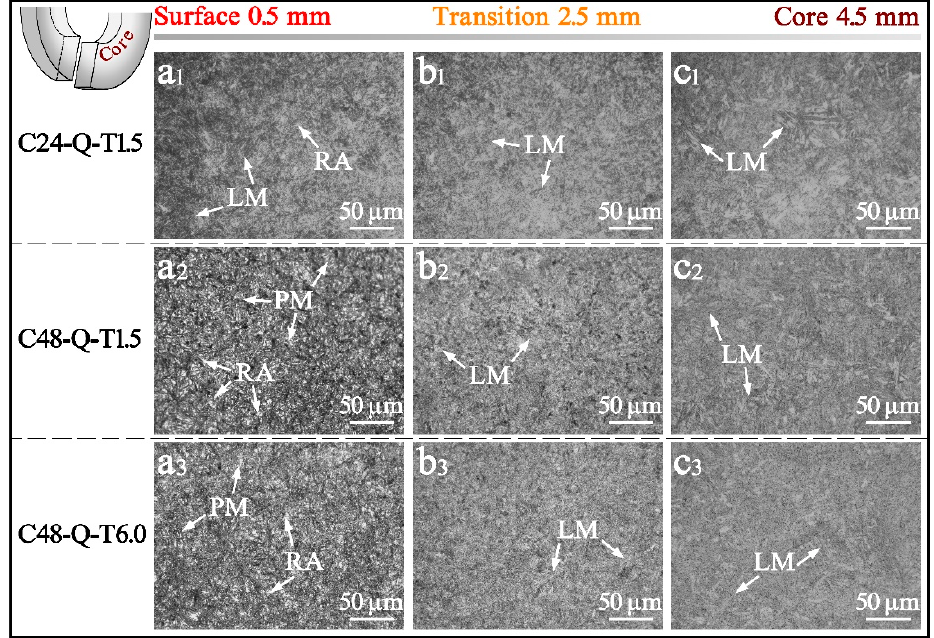
Figure 2. OM images from surface to core in the carburized layer of the specimens processed with different carburizing/tempering durations, where LM, PM and RA represent lath martensite, plate martensite and retained austenite, respectively.